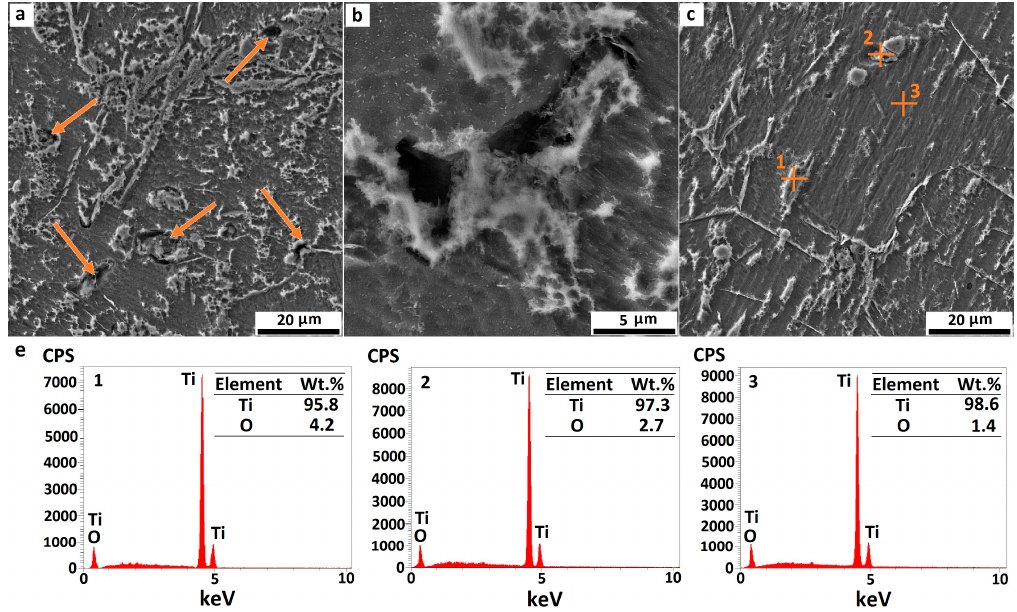
Figure 4. (a) SEM image of pure titanium composite sintered for 1 h (pores are shown with arrows), (b) high magnification image of a pore in pure titanium composite sintered for 1 h, (c) SEM image of pure titanium composite sintered for 5 h, and (d) energy-dispersive detector (EDS) analysis of selected points in (images 1, 2 and 3 represent the EDS analysis of points 1, 2 and 3 in (c), respectively).